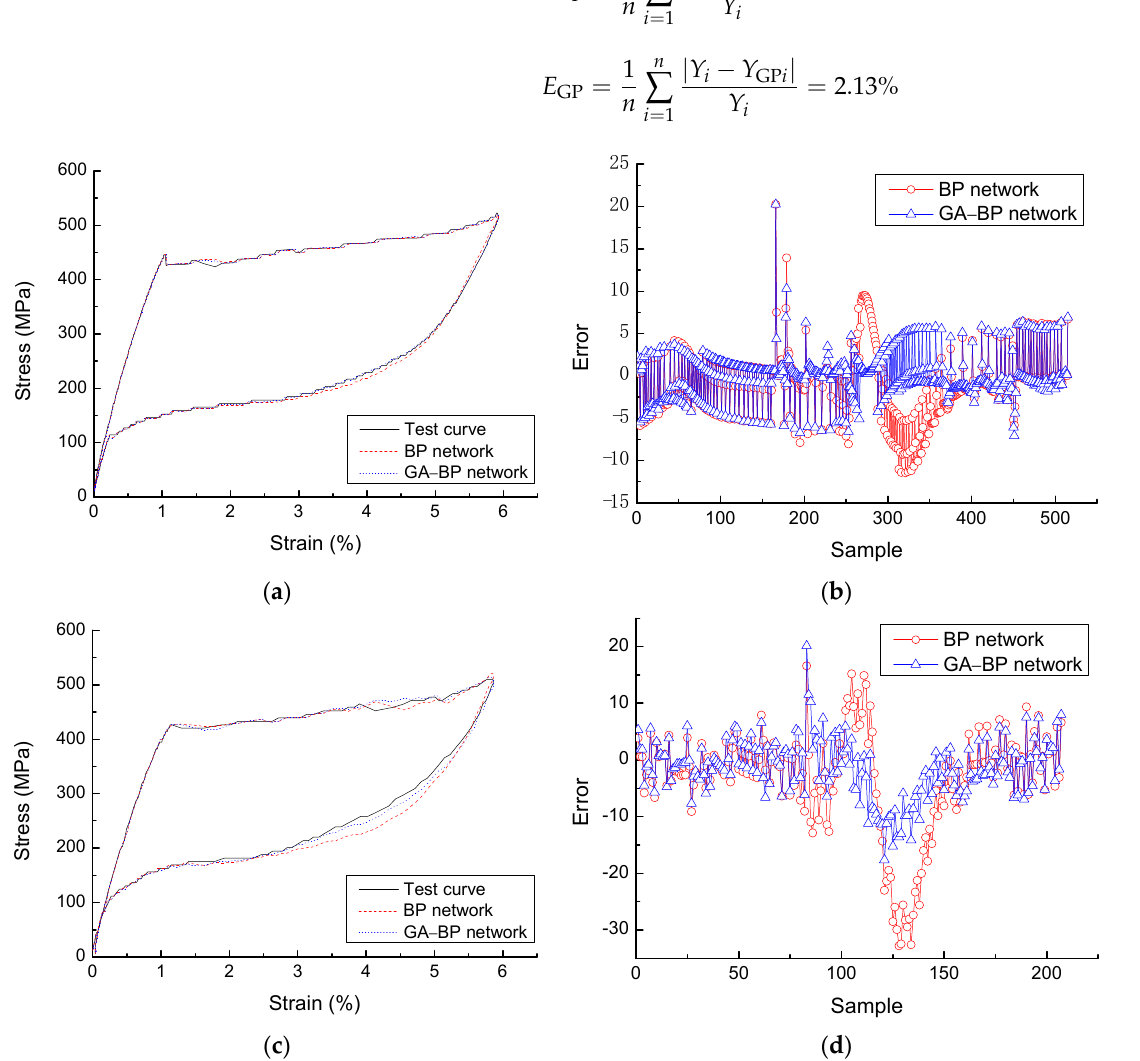
Figure 10. Comparison and corresponding error between test curve and prediction curves of un-optimized and optimized BP network by GA, ( a ) constitutive curves at 30 mm/min, ( b ) error at 30 mm/min, ( c ) constitutive curves at 90 mm/min, ( d ) error at 90 mm/min.